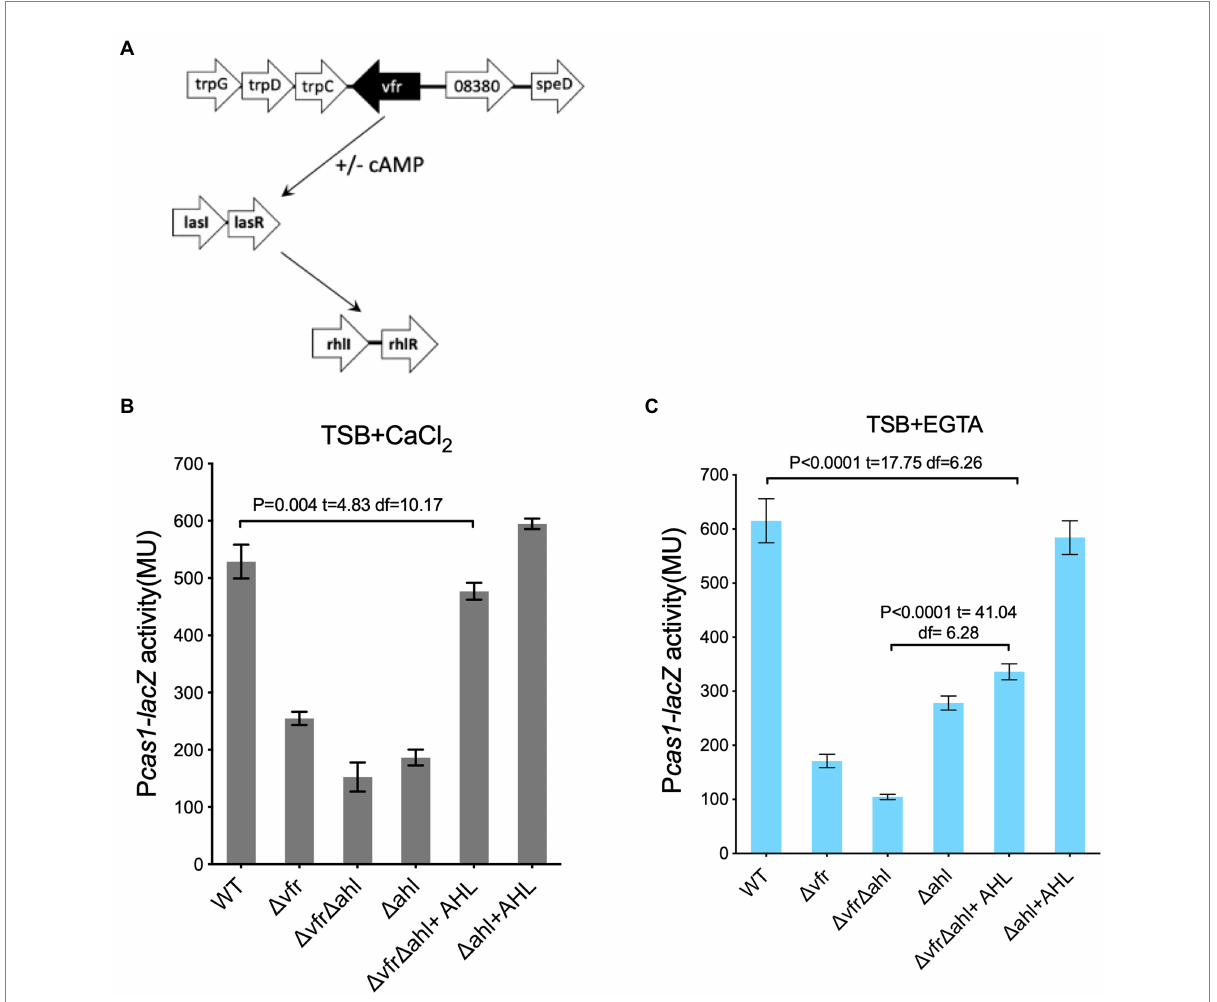
FIGURE 4 Vfr regulates the CRISPR-Cas system via AHL QS system. (A) Diagrammatic representation of Vfr and AHL QS regulation in P. aeruginosa . The expression of cas1 in the WT and mutants Δ vfr , Δ lasI Δ rhlI designated as ( Δ ahl) and Δ vfr Δ ahl strains grown in (B) , calcium-rich and (C) , calcium-rich media. Exogenous QS molecules (AHL) were added to the media as indicated. Data shown are the mean ± SD ( n = 6). Statistical analysis was conducted by student’s t -test with a p value of < 0.05 is considered